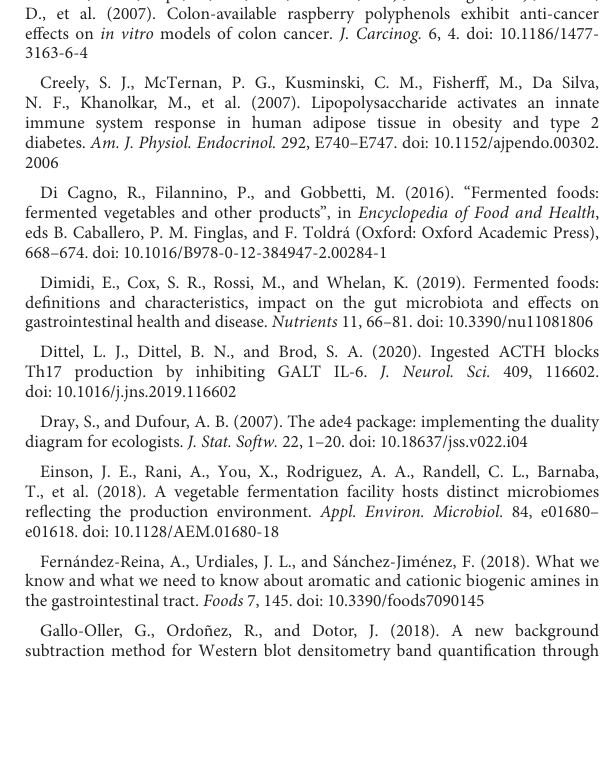
SUPPLEMENTARYFIGURES1 Schematic illustration of in vitro model of the intestinal epithelium. Human adenocarcinoma cells (Caco-2) were grown to confluence, and then co-cultured with peripheral blood mononuclear cells (PBMCs) to mimic the intestinal epithelial barrier. Trans-epithelial electrical resistance (TEER) was measured after 24h of incubation with sauerkraut fermentation brine as an index of intestinal integrity. The potential anti-inflammatory effect of sauerkraut brine was evaluated by measuring cytokine release into the basolateral and apical side upon PBMC exposure to lipopolysaccharide (LPS) for 24h, following 2h of pre-incubation in the presence or absence of 10% sauerkraut water. Tight junction (TJ) proteins in Caco-2 cells were measured by Western blot. Gene expression analysis of cytokines and TJ proteins was also performed. SUPPLEMENTARYTABLES1 Metabolite concentration (mg/L) in sauerkraut brine quantified by 1 H-NMR. Data represent the mean and standard deviation (SD) after 1, 2, 3, 7, 14, 21, 28, and 35 days of fermentation. Producer 1 (SK1) (A) and producer 2 (SK2) (B) . DMSO, dimethyl sulfoxide; dUMP, deoxyuridine monophosphate; GABA, γ -aminobutyric